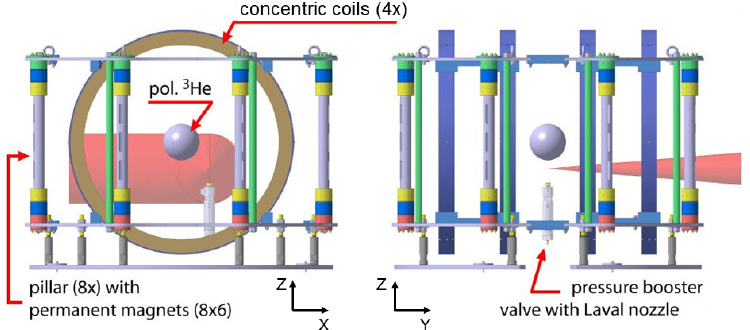
Figure 2. Arrangement of the magnet system with permanent magnets and four concentric coils. The transport vessel with 3 He (gray sphere) can be seen at the center and the compressor below. The PHELIX laser beam is indicated by the red cone.